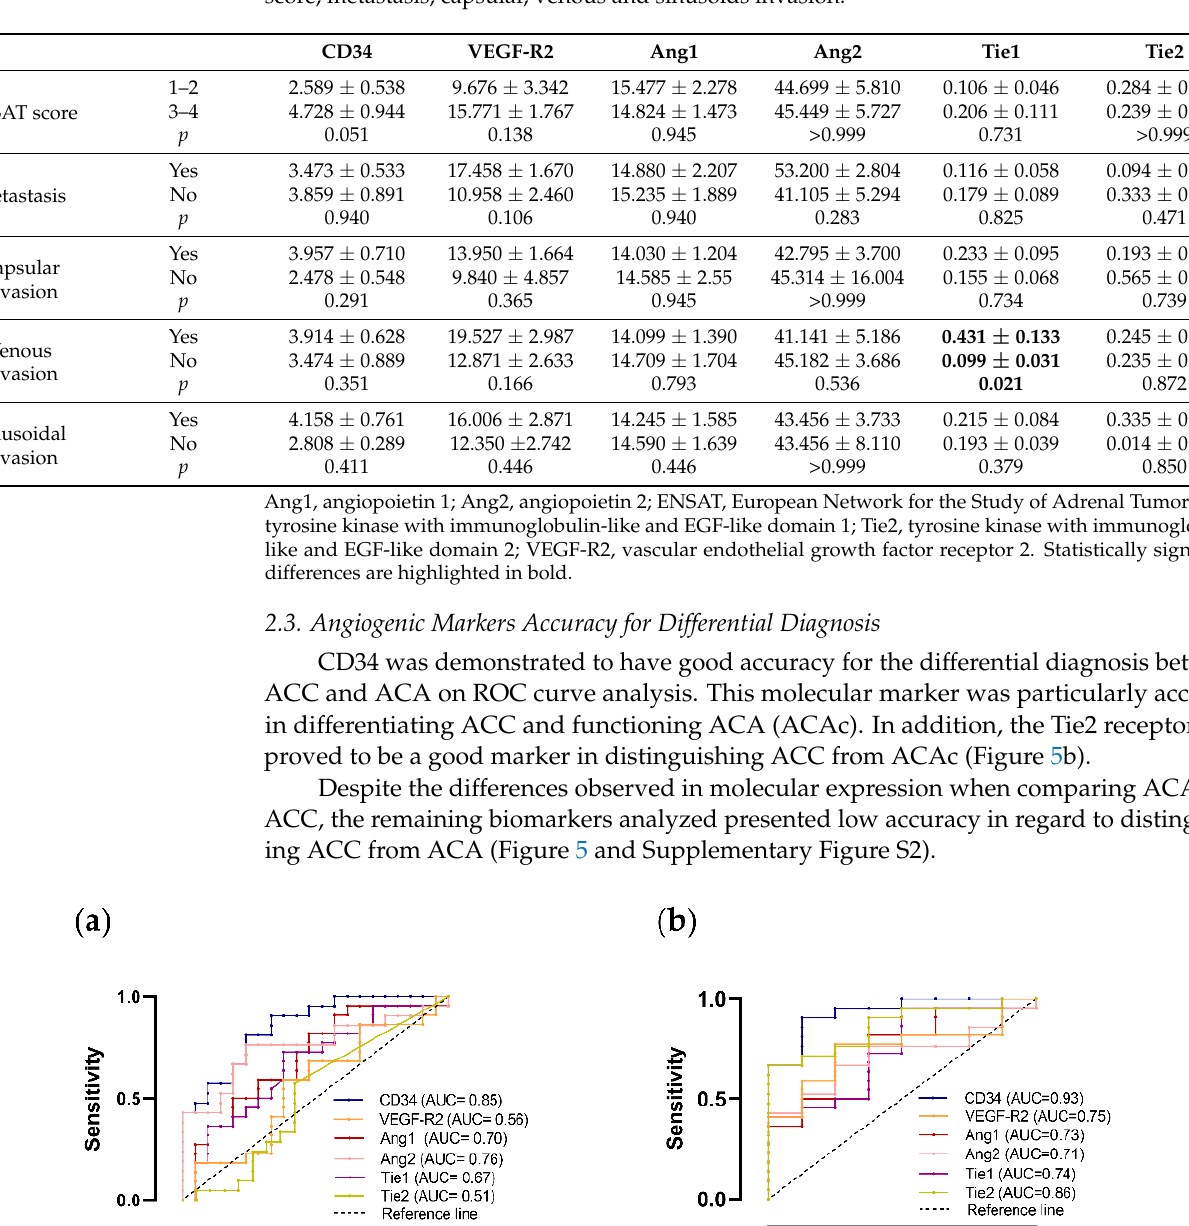
Figure 5. Graphic representation of ROC curve to distinguish adrenocortical carcinoma (ACC) and total adrenocortical adenomas (ACAt) ( a ); ACC and adrenocortical adenoma with Cushing syn- drome (ACAc) ( b ); ACC and non-functioning adrenocortical adenoma (ACAn) ( c ) with the respec- tive area under the curve (AUC). 2.4. Angiogenic Markers Accuracy to Predict ACC Prognosis There was no significant difference in angiogenic markers expression nor VEGF ex- pression pattern in ACC according to patient overall survival. A higher Tie1 expression was found in most patients with lower survival (Table 3). Table 3. Overall survival in patients with ACC. Angiogenic Marker